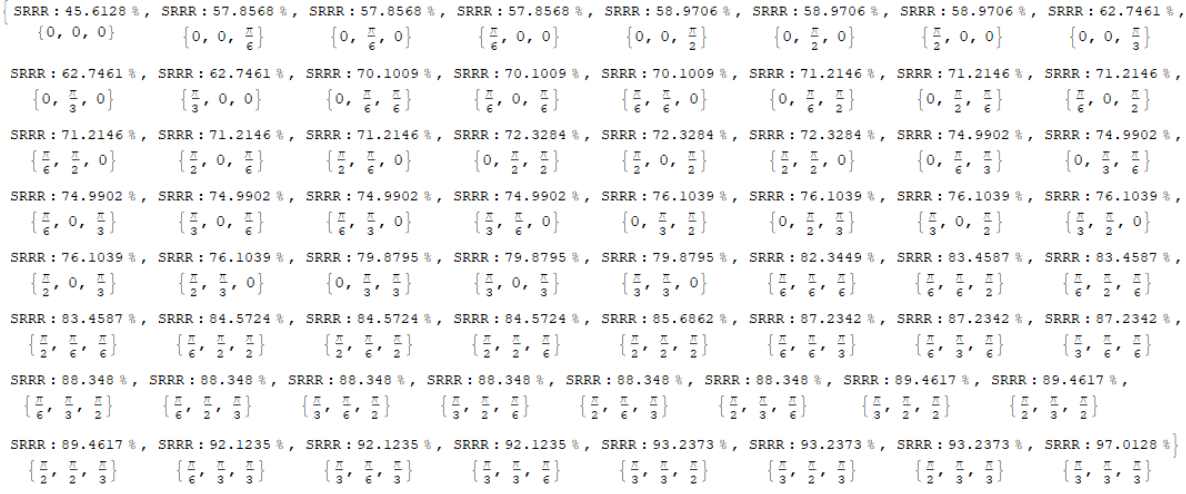
Makkah, Saudi Arabia.